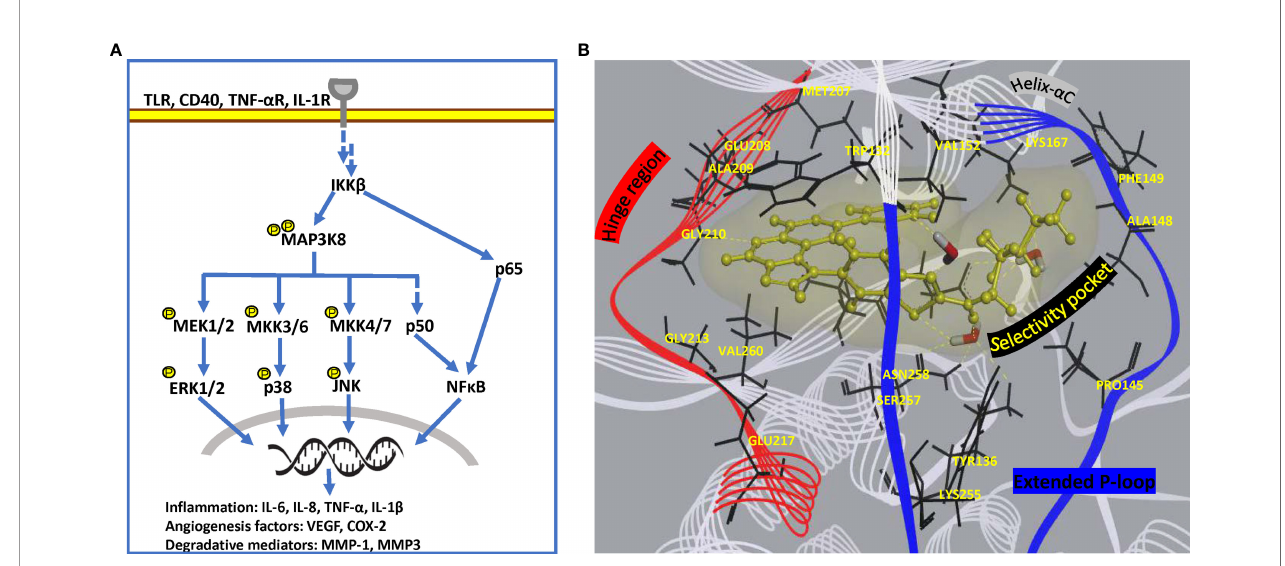
FIGURE 5 | Pathway and structural details of MAP3K8 as potential drug target. (A) Diagrammatic representation of MAP3K8 signaling in innate and stromal cells for persistent in fl ammation. (B) Unique binding mode of a preclinical inhibitor in MAP3K8 kinase domain (PDB: 5IU2). Active site residues providing hydrogen bond and hydrophobic interactions are present in hinge region, helix- a C element as well as selectivity pocket formed due to extended fl exible P-loop of kinase domain. Secondary structure of kinase domain is rendered as line ribbon including P-loop in blue, hinge region in red and rest of the domain in white. Key residues of the domain are rendered as black sticks, water molecules as sticks in element color and inhibitor as yellow ball and stick model. Soft surface of inhibitor is depicted in light yellow and hydrogen bond interactions as yellow dashed